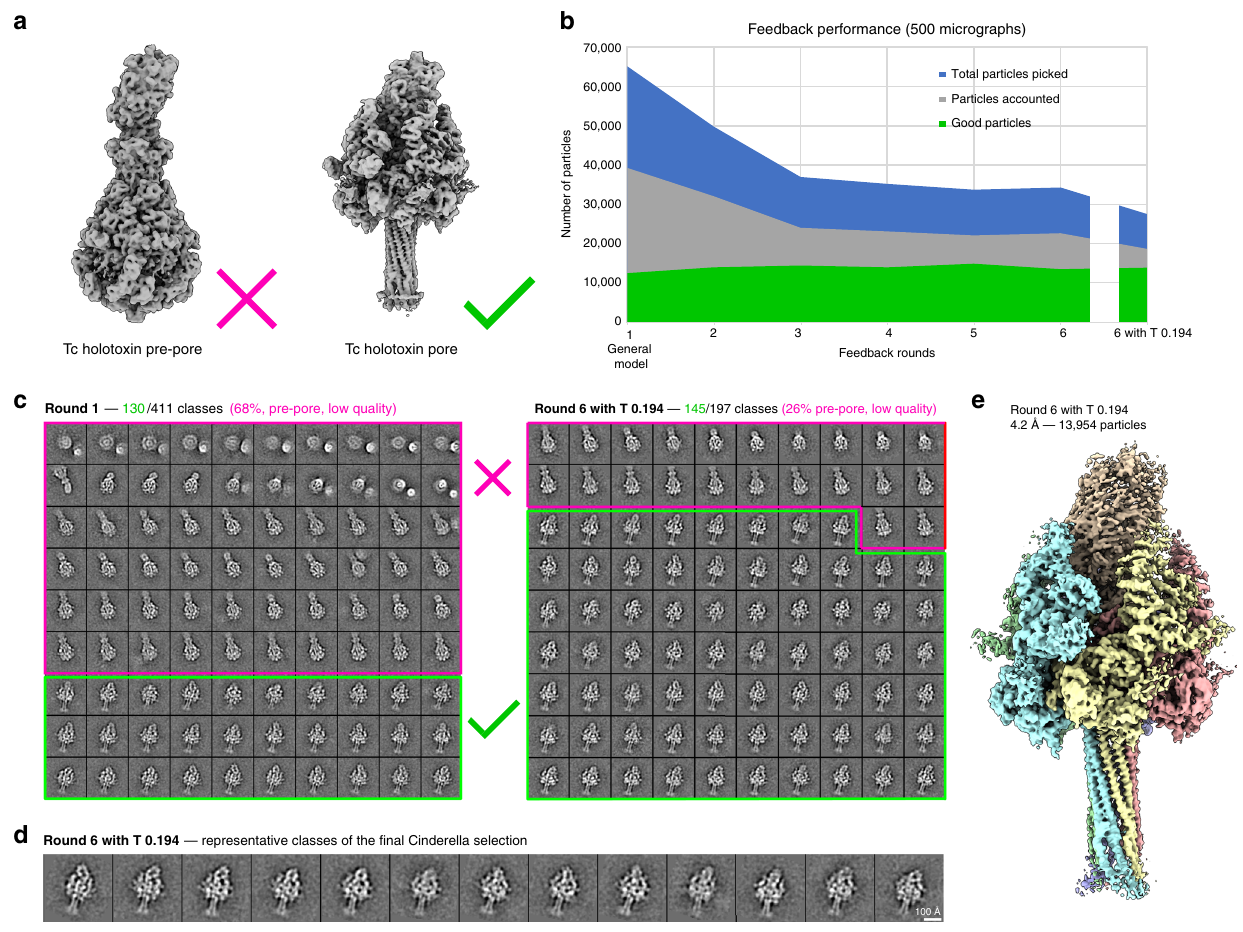
Fig. 4 Using prior knowledge to extract a pre-selected conformational state. a The processed data set contains the Tc holotoxin in both the pre-pore state (left) and the more rare pore state (right). In this experiment, we speci fi cally target the pore state. b Progression of the number of picked particles (blue), those accounted during 2D classi fi cation (gray) and particles labeled “ good ” i.e. representing the pore state (green) when applying the intermediate picking models of the feedback loop to a fi xed subset of 500 micrographs. Initial picking is dominated by pre-pore state particles. This overhead is reduced with each iteration, while the amount of picked pore state particle remains stable. c Representative 2D class averages depicting the decrease of unwanted classes (pore state or low quality; marked magenta) from an initial 68% in the fi rst feedback round (left) to 26% after the last feedback round (right). d Representative 2D class averages depicting the pore state as selected by Cinderella in the fi nal iteration of the feedback loop. e 3D reconstruction of the Tc holotoxin pore state computed from 500 micrographs using the fi nal optimized picking